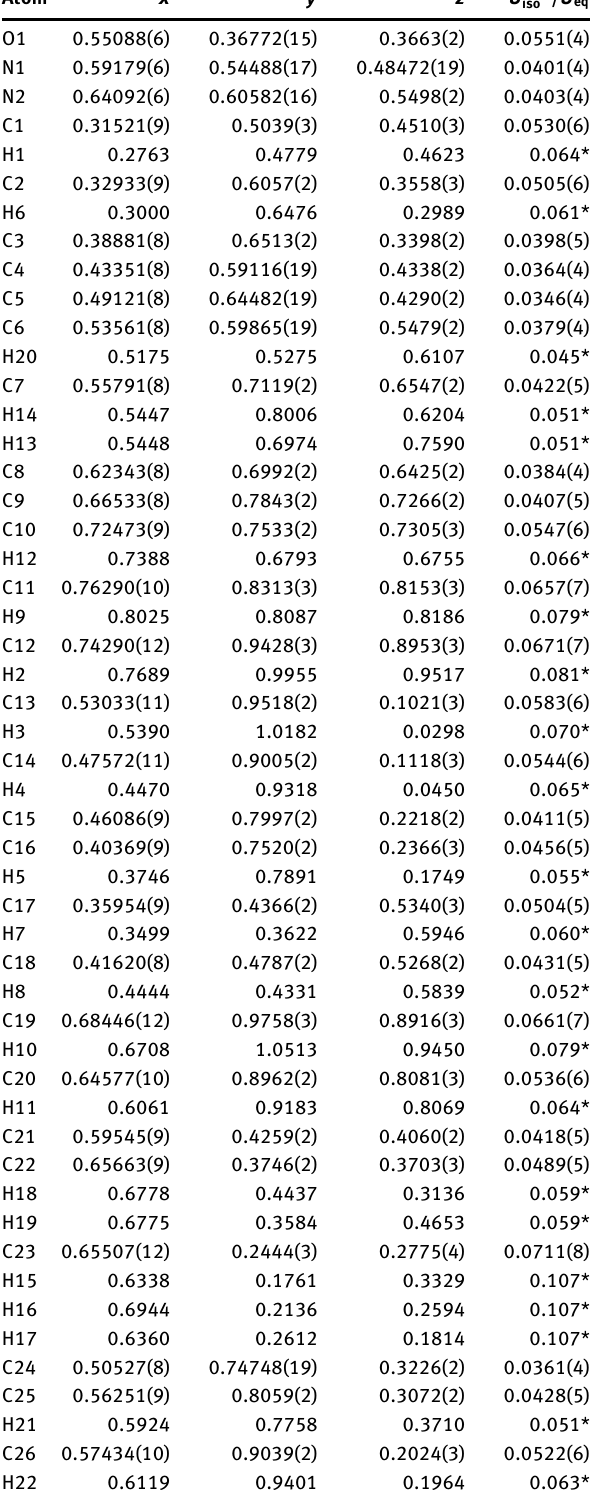
Table 2: Fractional atomic coordinates and isotropic or equivalent isotropic displacement parameters (Å 2